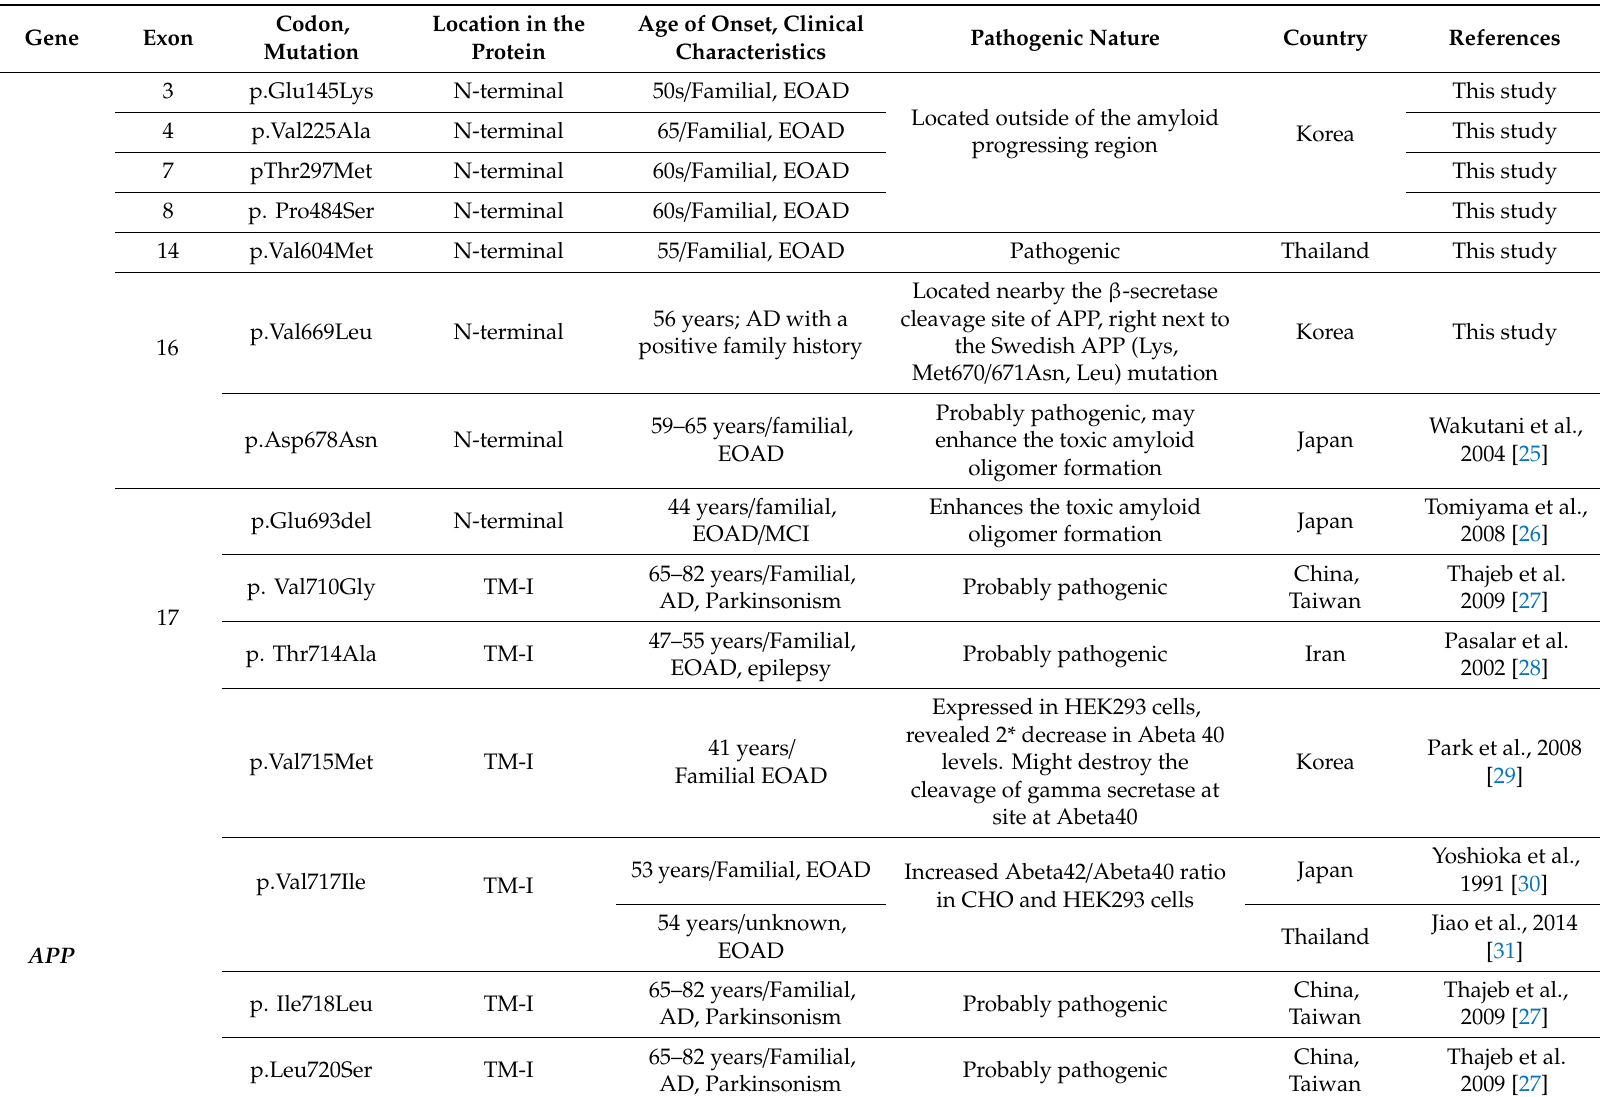
Table 2. The spectrum of APP, PSEN1 , and PSEN2 mutations found in Asian